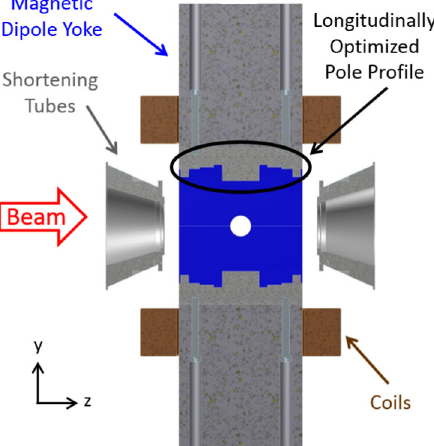
FIG. 3. Cross section of the chopper dipole in the y − z plane. Shortening tubes and a longitudinally optimized pole profile are used to match the shapes of magnetic and electric deflection forces [3,32].